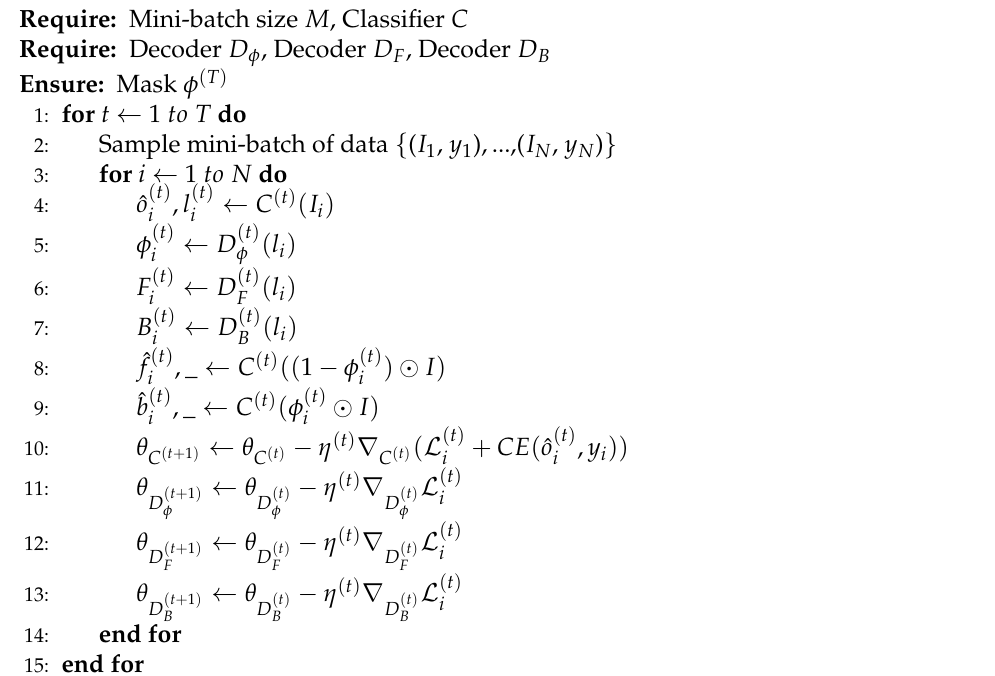
Algorithm 2 Mumford–Shah Segmentation